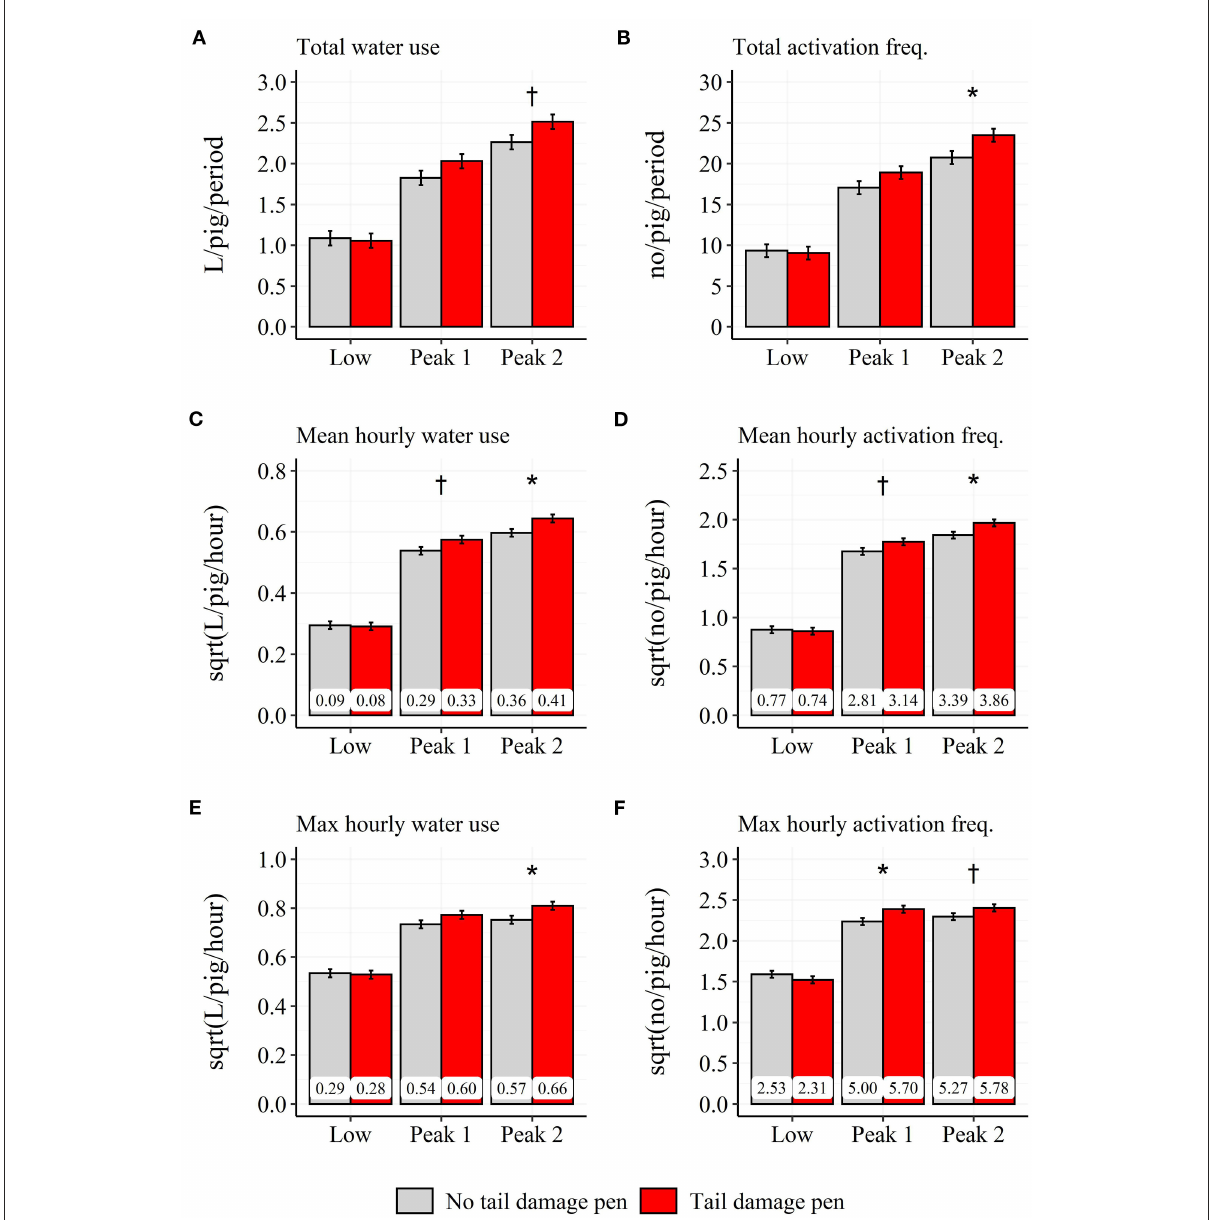
FIGURE9 Difference between pens with and without tail damage across the 3 days prior to and the day of the tail damage event in model-estimated daily total (A,B) , mean-hourly (C,D) and max hourly (E,F) , water use (A,C,E) and activation frequency (B,D,F) during the three time periods: Low: 18:00–05:59h; Peak 1: 06:00–11:59h; Peak 2: 12:00–17:59h. Error-bars represent standard errors of the mean. The back-transformed model estimates are shown within each bar. † P < 0.1, * P < 0.05 between pens with and without tail